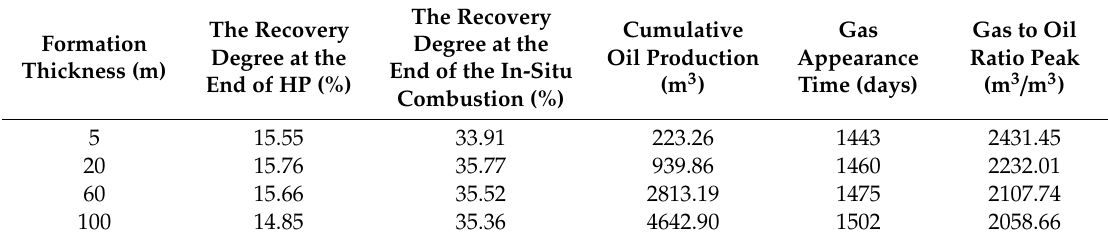
Table 18. Dynamic production indicators under di ff erent formation thickness.